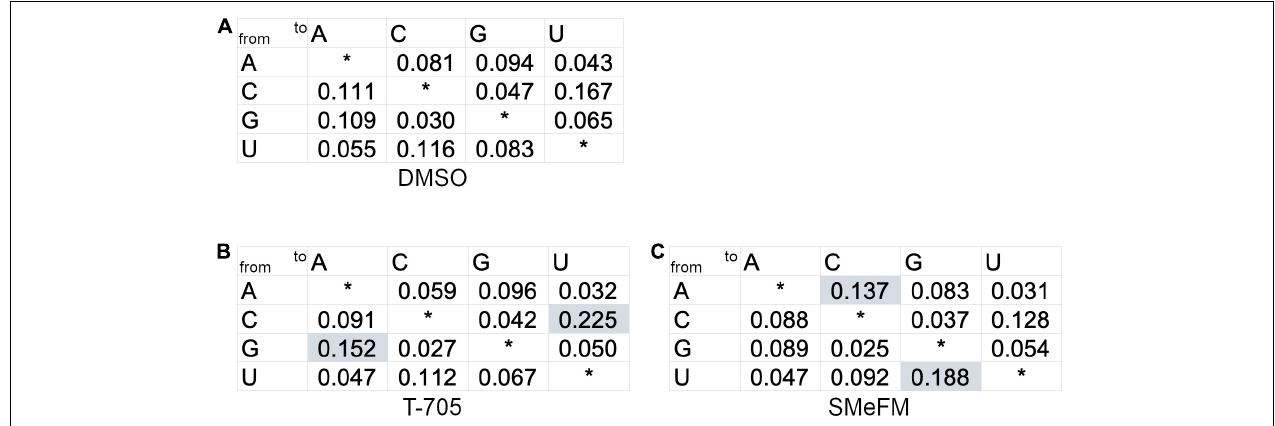
FIGURE 6 | Adenine to cytosine and uracil to guanine mutations are accumulated in viral genome RNA by the treatment of SMeFM. The mutation rate from treated infected cells treated with DMSO (A) , T-705 (B) , or SMeFM (C) was shown. The mutation ratio was calculated from the number of polymorphisms of each nucleotide and the total number of polymorphisms (DMSO: 40,640, T-705: 57,923, and SMeFM: 33,161) detected by amplicon-seq. A chi-square test was used to determine the statistical significance of the differences of each mutation type relative to the DMSO control. Statistically significant increases in mutation rates are highlighted by